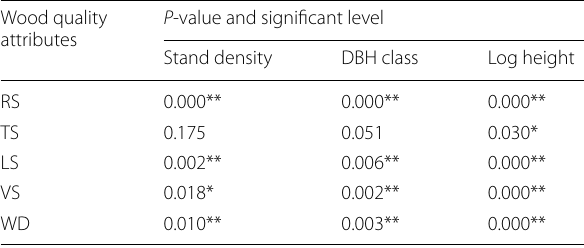
Table 2 ANOVA analysis of the effects of initial stand density, DBH class and log height on wood shrinkage and wood density Wood quality attributes